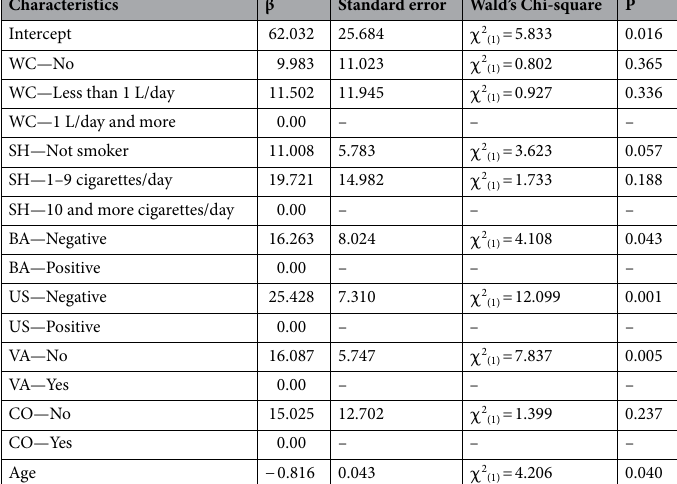
Table 4. Results of the generalized linear model with sperm/ml × 10 6 (C) as response variable. WC wine consumption, SH smoking habit, BA semen bacteriological analysis, US urethral swab, VA varicocele, CO consanguinity.